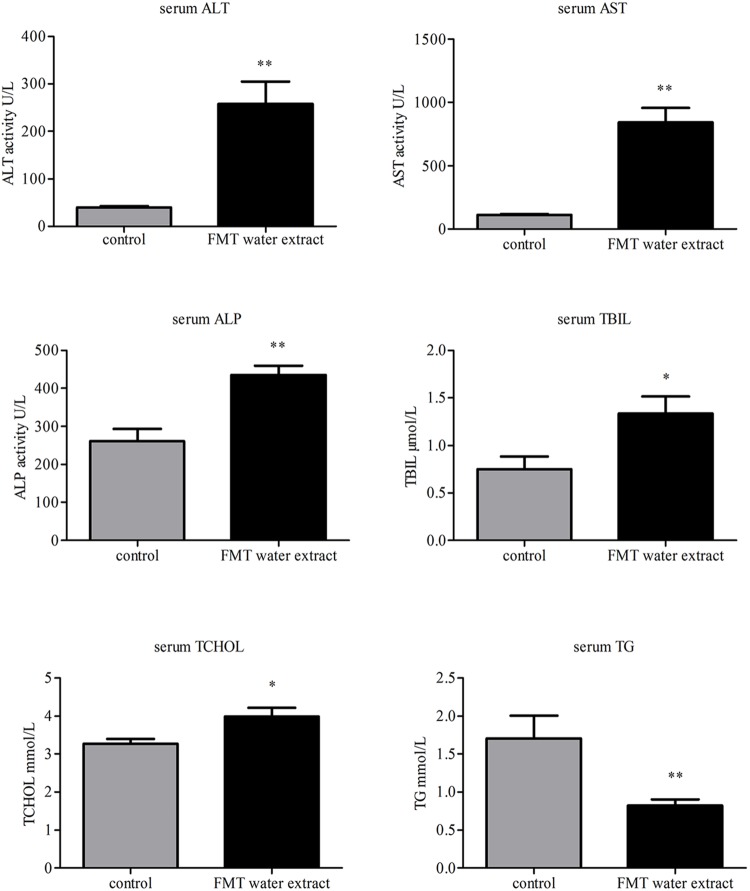
Effects of FMT water extract on serum biochemical parameters after intragastric administration of 240 g/kg FMT water extract for 3 days in mice (control group: n = 8; FMT water extract group: n = 14). Values are represented as mean ± SD (∗p < 0.05, ∗∗p < 0.01 compared with vehicle control group).